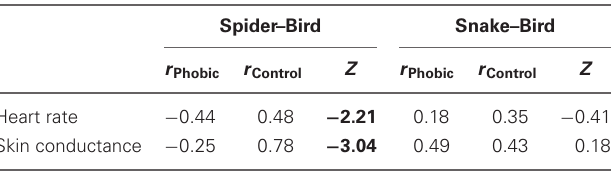
Table 3 | Correlations between gaze duration spider – bird / snake − bird and autonomic responses spider – bird / snake − bird